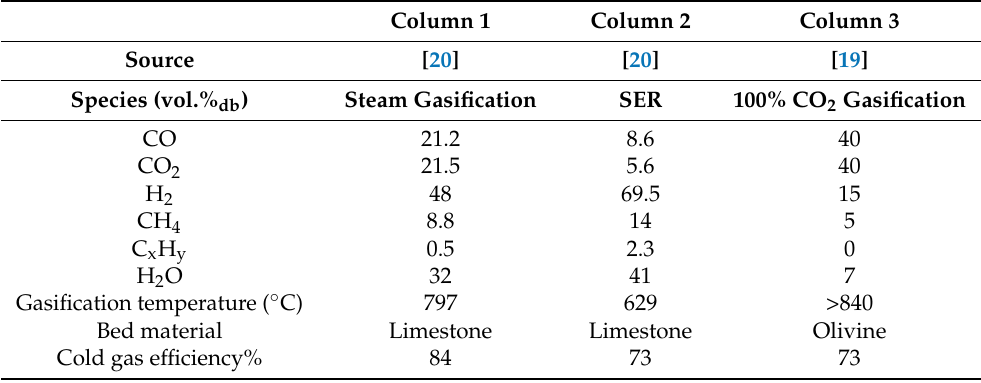
Table 1. Different syngas compositions depending on gasification type based on research activities from TU Wien. Column 1 Column 2 Column 3 Source [20] Species (vol.% db